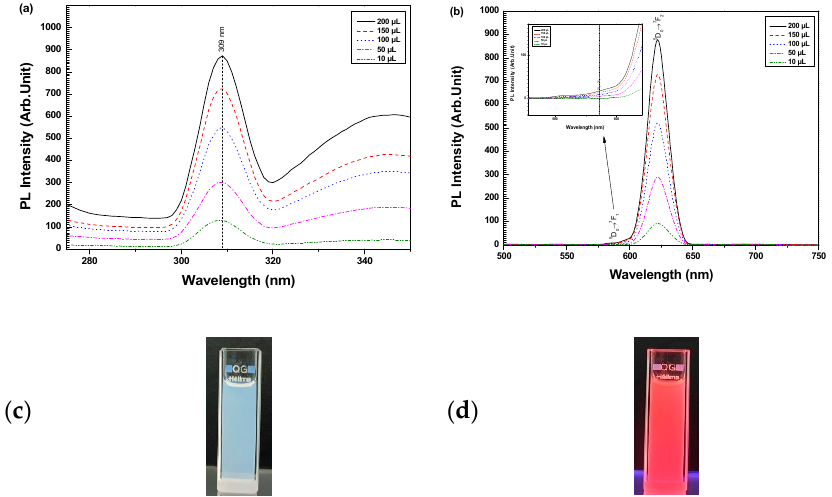
Figure 5. ( a ) Excitation (309 nm) and ( b ) emission (621 nm) spectra depending on different concentrations of Eu(TTA) 3 (P(Oct) 3 ) 3 @mSiO 2 @SPION. Photographic images of Eu(TTA) 3 (P(Oct) 3 ) 3 @mSiO 2 @SPION diluted in DI water at ( c ) room light and ( d ) UV